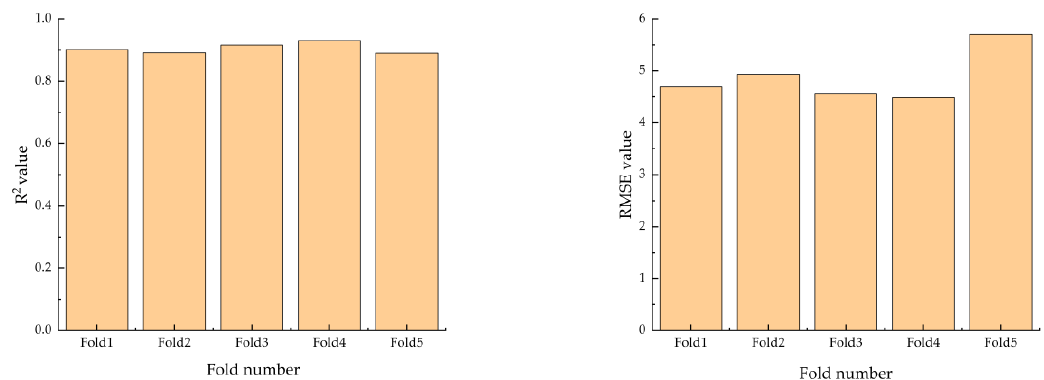
Table 9. Five-fold cross validation results.